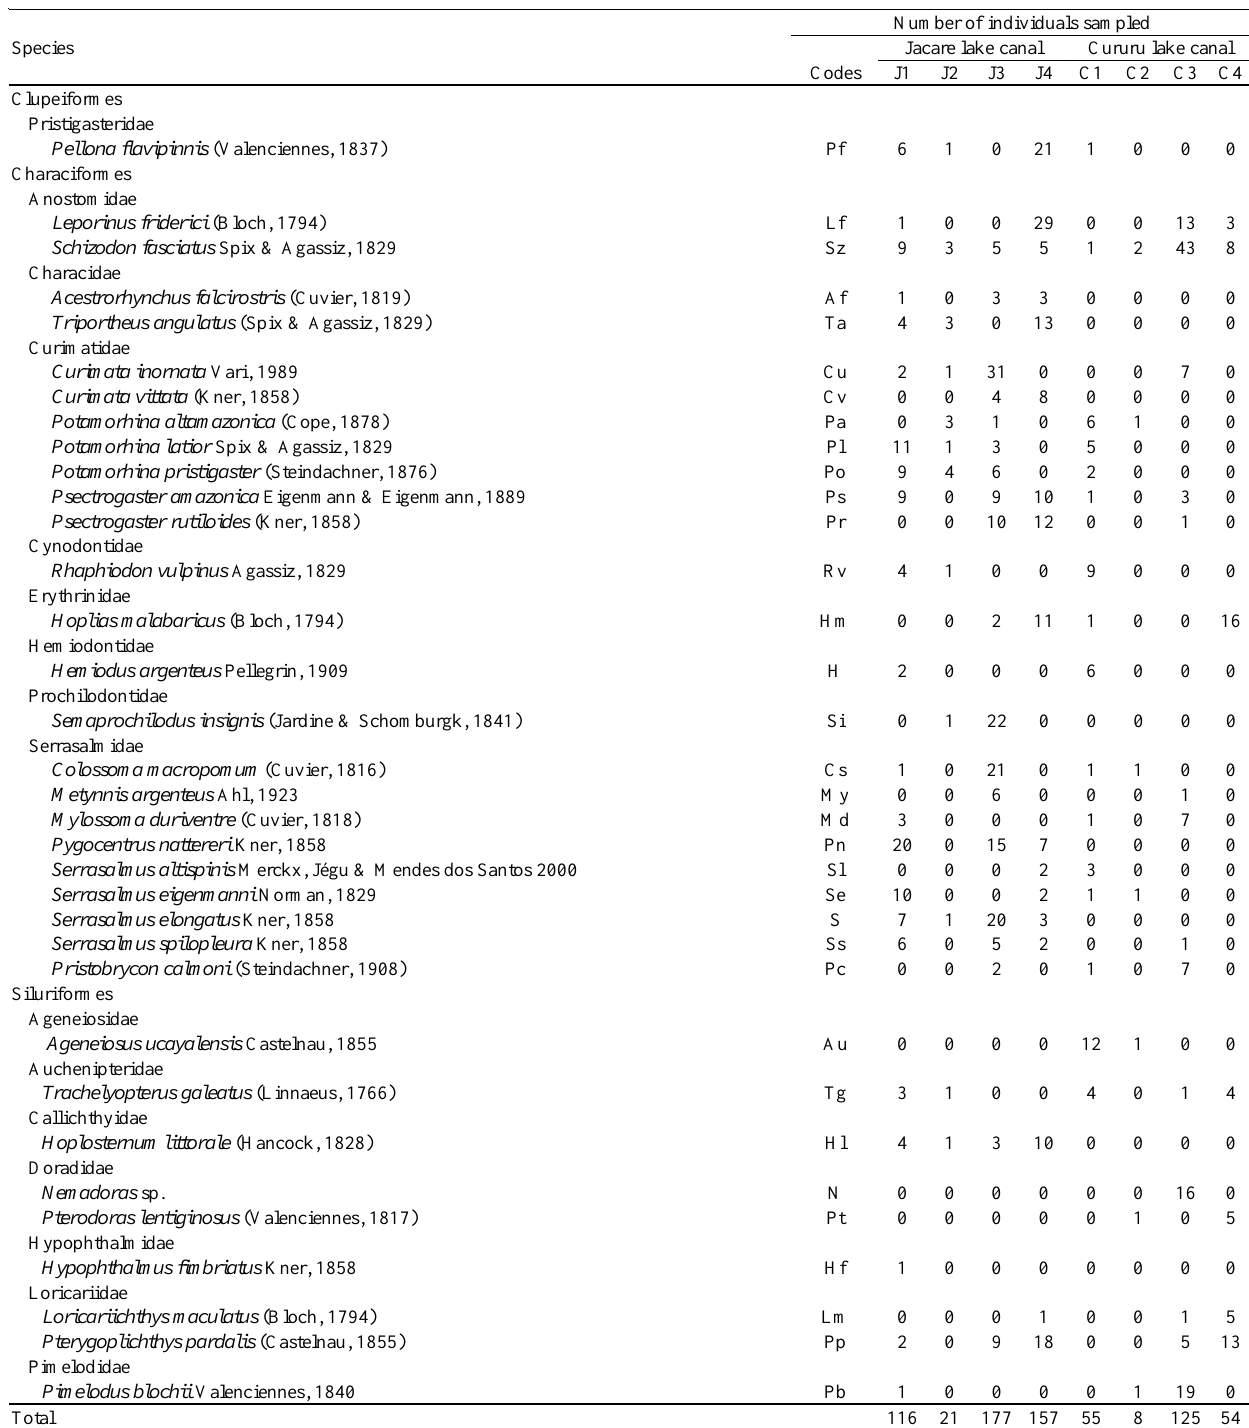
Table 2. Number of individuals captured for every species of the lake canals studied and codes used in the analyses. (J = Jacaré lake canal; C = Cururu lake canal; 1 = Rising water period; 2 = Flood period; 3 = Receding water period; 4 =